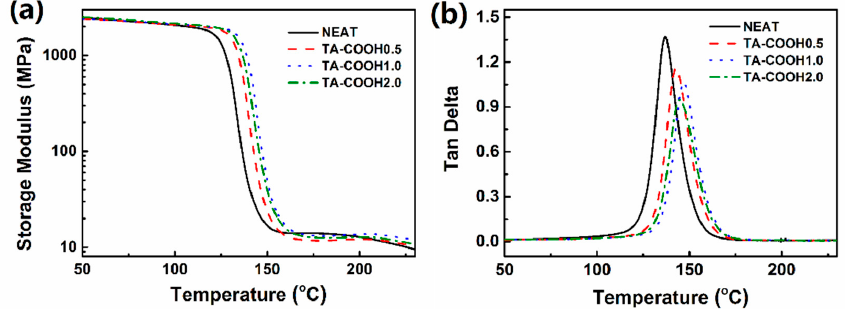
Figure 4. Storage modulus ( a ) and tan delta ( b ) versus temperature for the neat epoxy and TA–COOH modified epoxy resins.